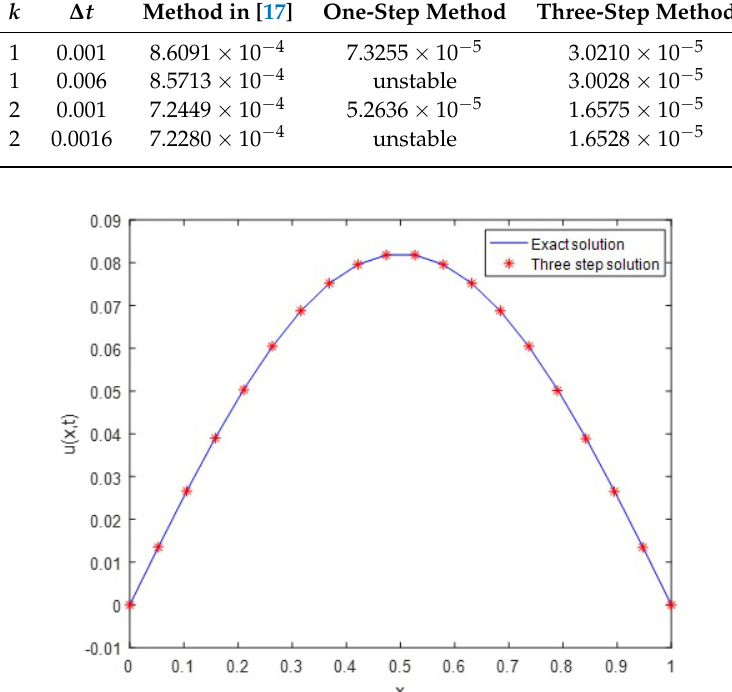
Figure 3. The exact and approximate solutions of Example 2 in the case M = 8, k = 2 and ∆ t =